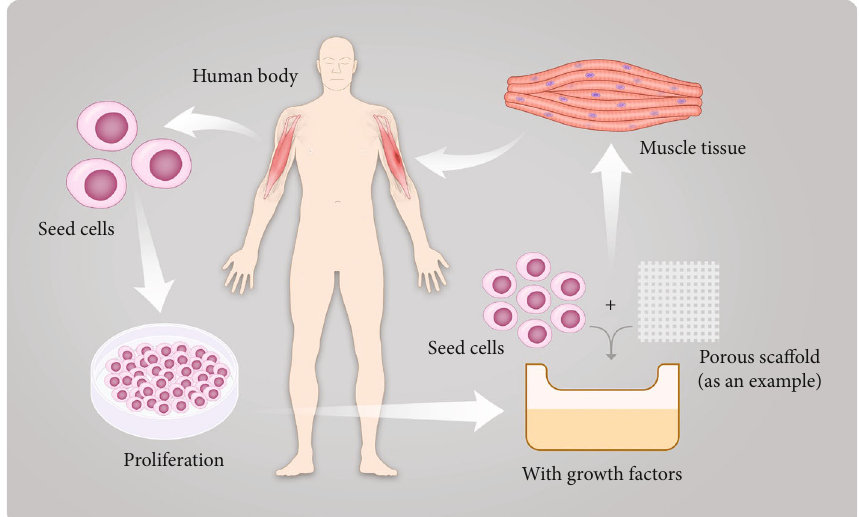
Figure 2: Schematic diagram of the general process of skeletal muscle tissue engineering. Taking the method of treating the biceps brachii defect with porous sca ff olds as an example. First, seed cells are obtained from the biceps brachii on the healthy arm and are cultured in vitro. Next, we should make seed cells attached to porous sca ff olds and add growth factors. Finally, a small amount of healthy skeletal muscle tissue is obtained and then implanted into the human